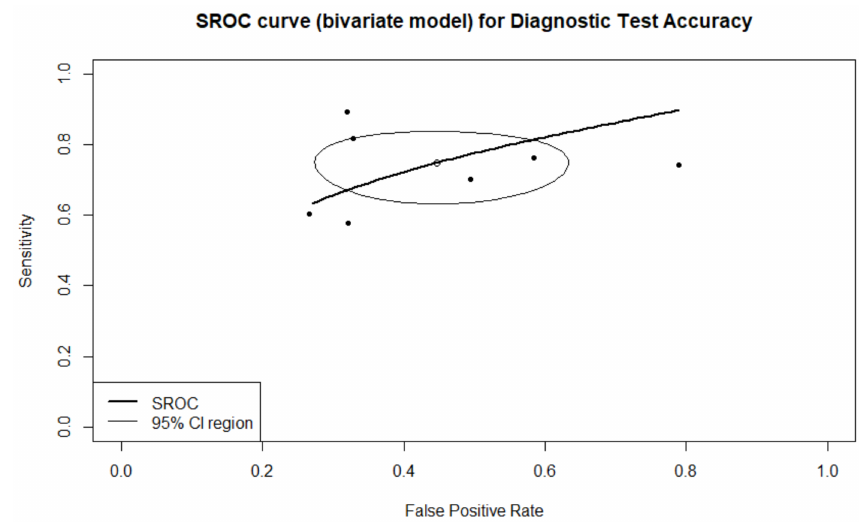
Figure 7. SROC of prediction of clinical pregnancy with fetal heartbeat.